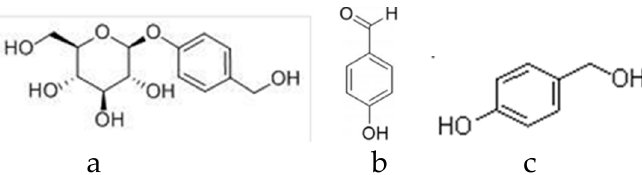
Figure 4. The structures of some compounds in the G. elata tuber. ( a ) Gastrodin [34], ( b ) p -hydroxy benzaldehyde [35], and ( c ) p -hydroxybenzyl alcohol [36].